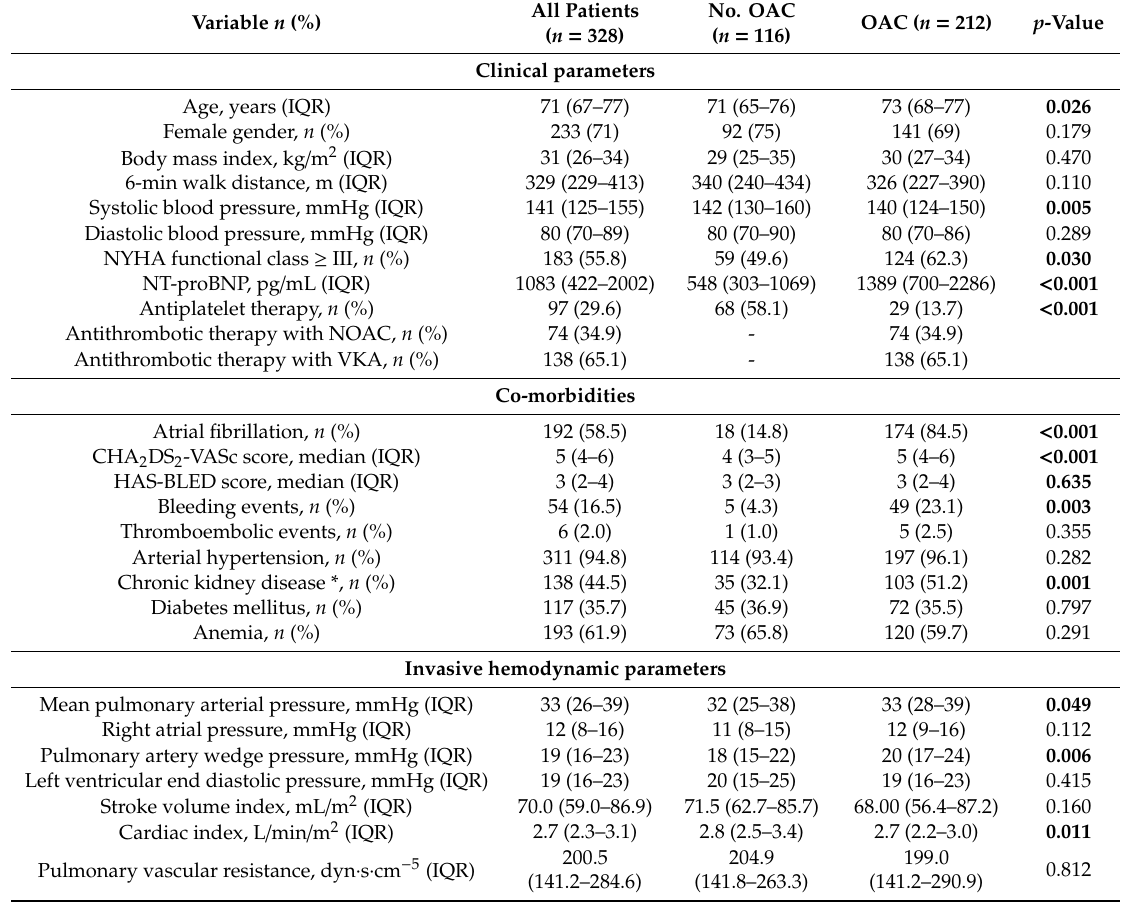
Table 1. Baseline characteristics of registered